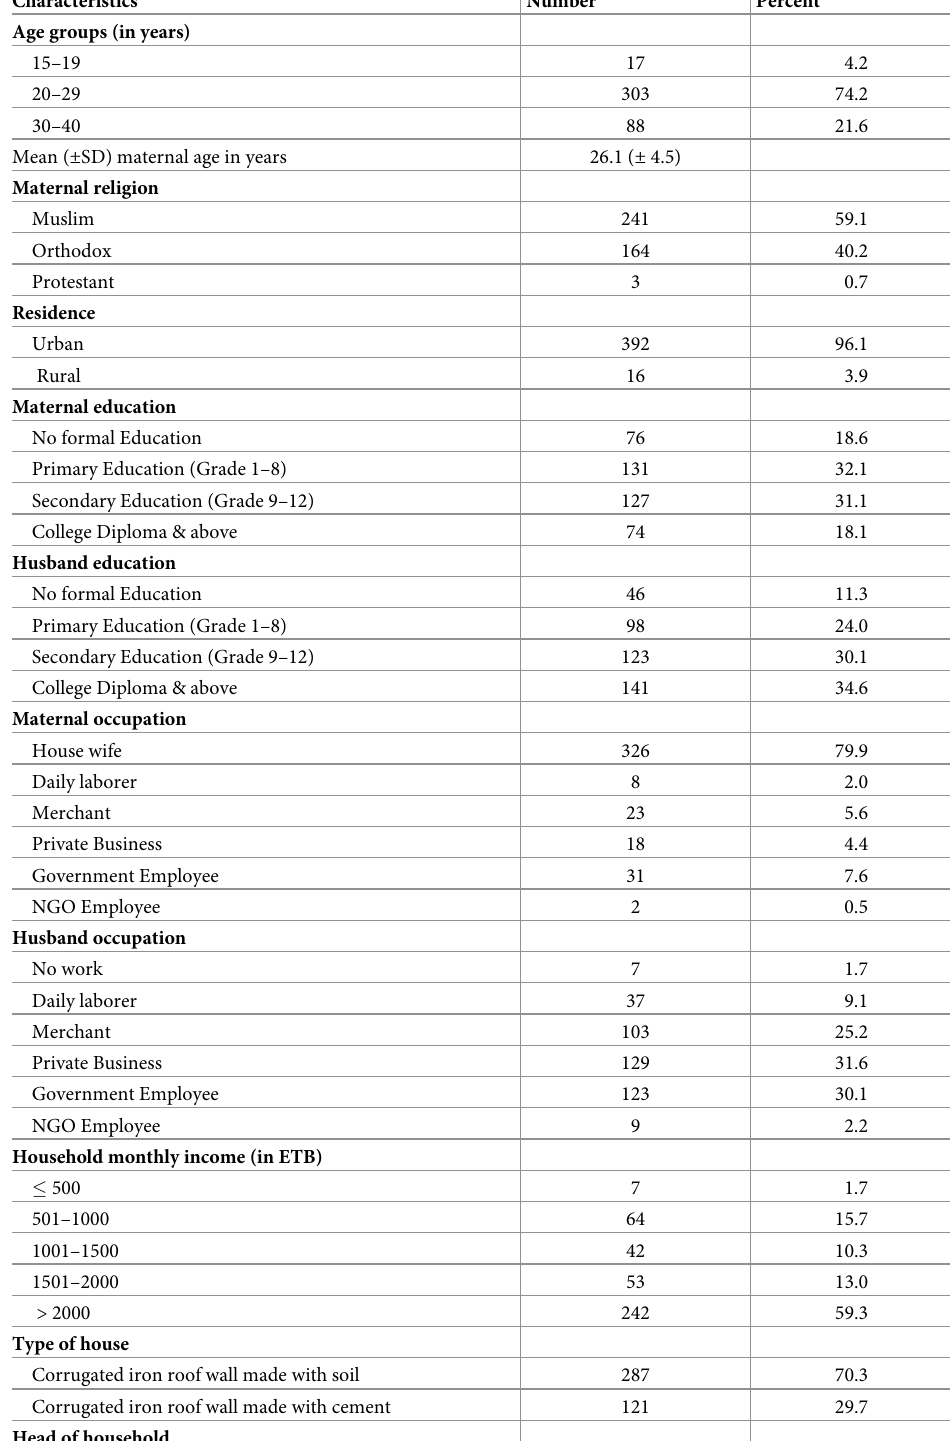
Table 1. Socio-demographic and economic characteristics of lactating mothers (n = 408) visiting governmental health facilities of Dessie town, Ethiopia, March-April,